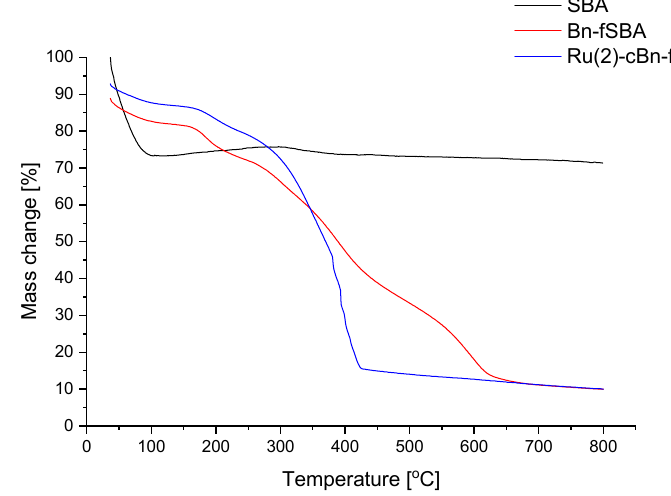
Figure 6. TGA analysis of SBA compounds.